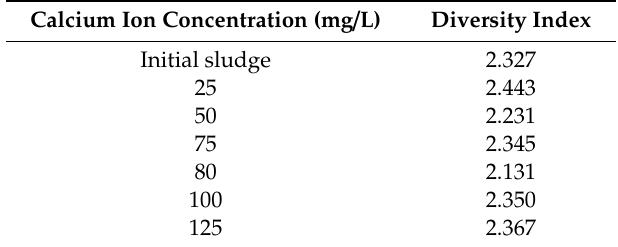
Table 3. Microbial diversity index of sludge samples from the seven reactors.